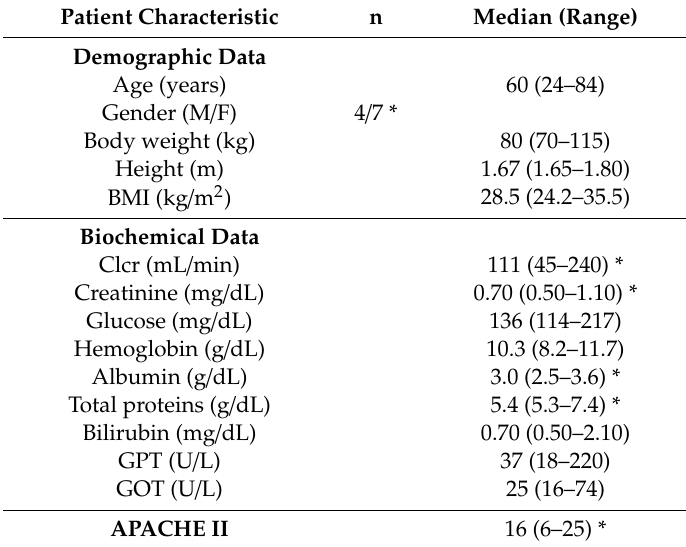
Table 2. Demographic and biochemical data and APACHE II health score of the patients used for the validation of the model. BMI: body mass index; Clcr: creatinine clearance; GOT: glutamate oxaloacetate transaminase; GPT: glutamate pyruvate transaminase. Patient